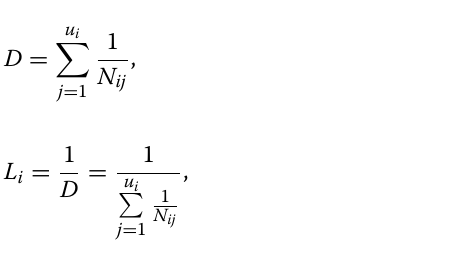
Table 2 Experimental data for GH4133 at R